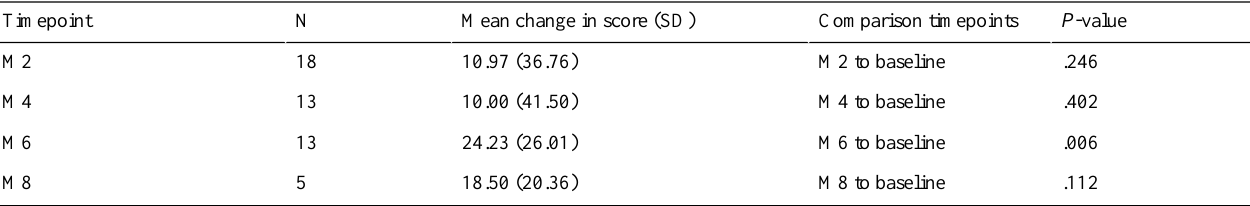
Table 9. Comparing patient baseline and follow-up COC a